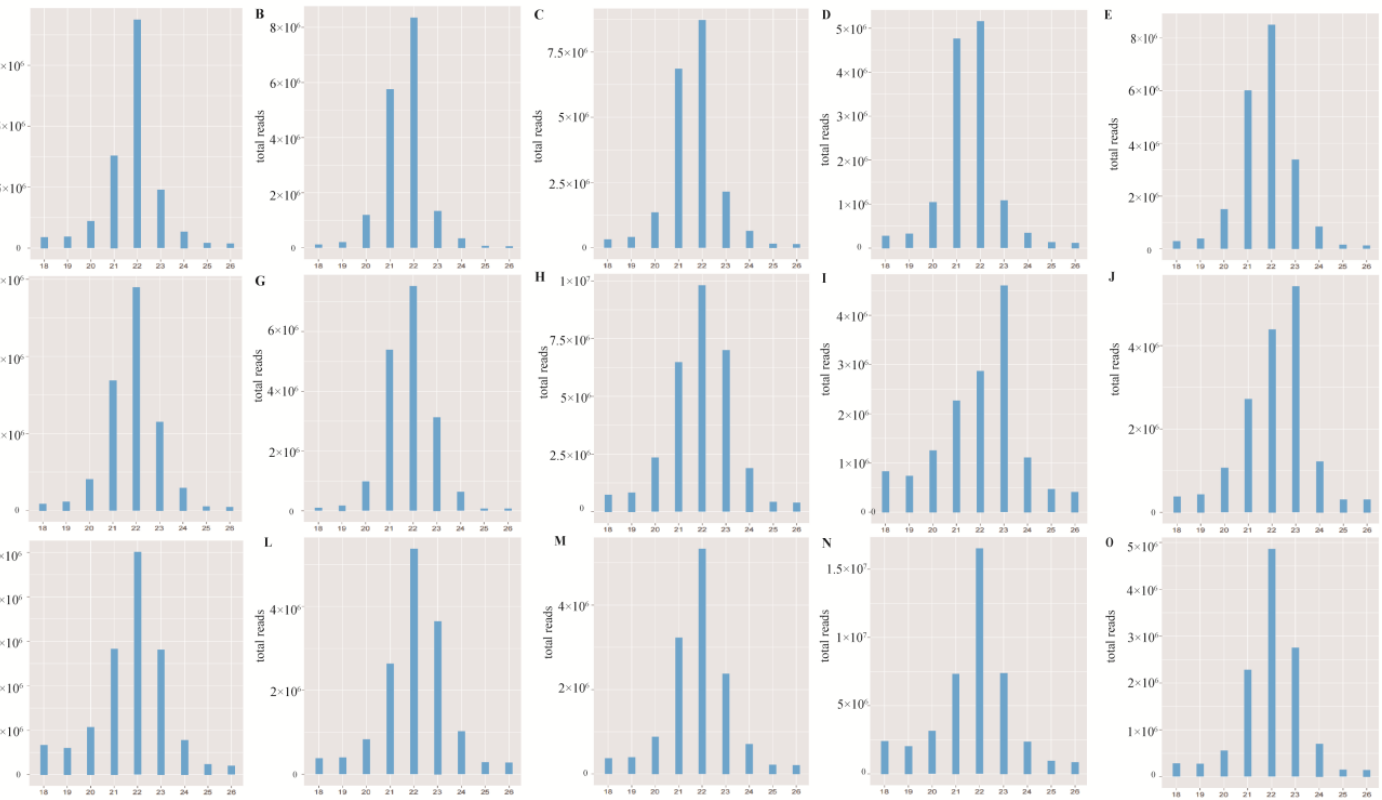
Figure A2. Length distribution of the read counts of sequencing data for small RNAs are shown for each goat involved in the study. A-O indicate the sample of CK1, CK2, CK3, Pm_d1_1, Pm_d1_2, Pm_d1_3, Pm_d2_1, Pm_d2_2, Pm_d2_3, Pm_d5_1, Pm_d5_2, Pm_d5_3, Pm_d7_1, Pm_d7_2 and Pm_d7_3, respectively.